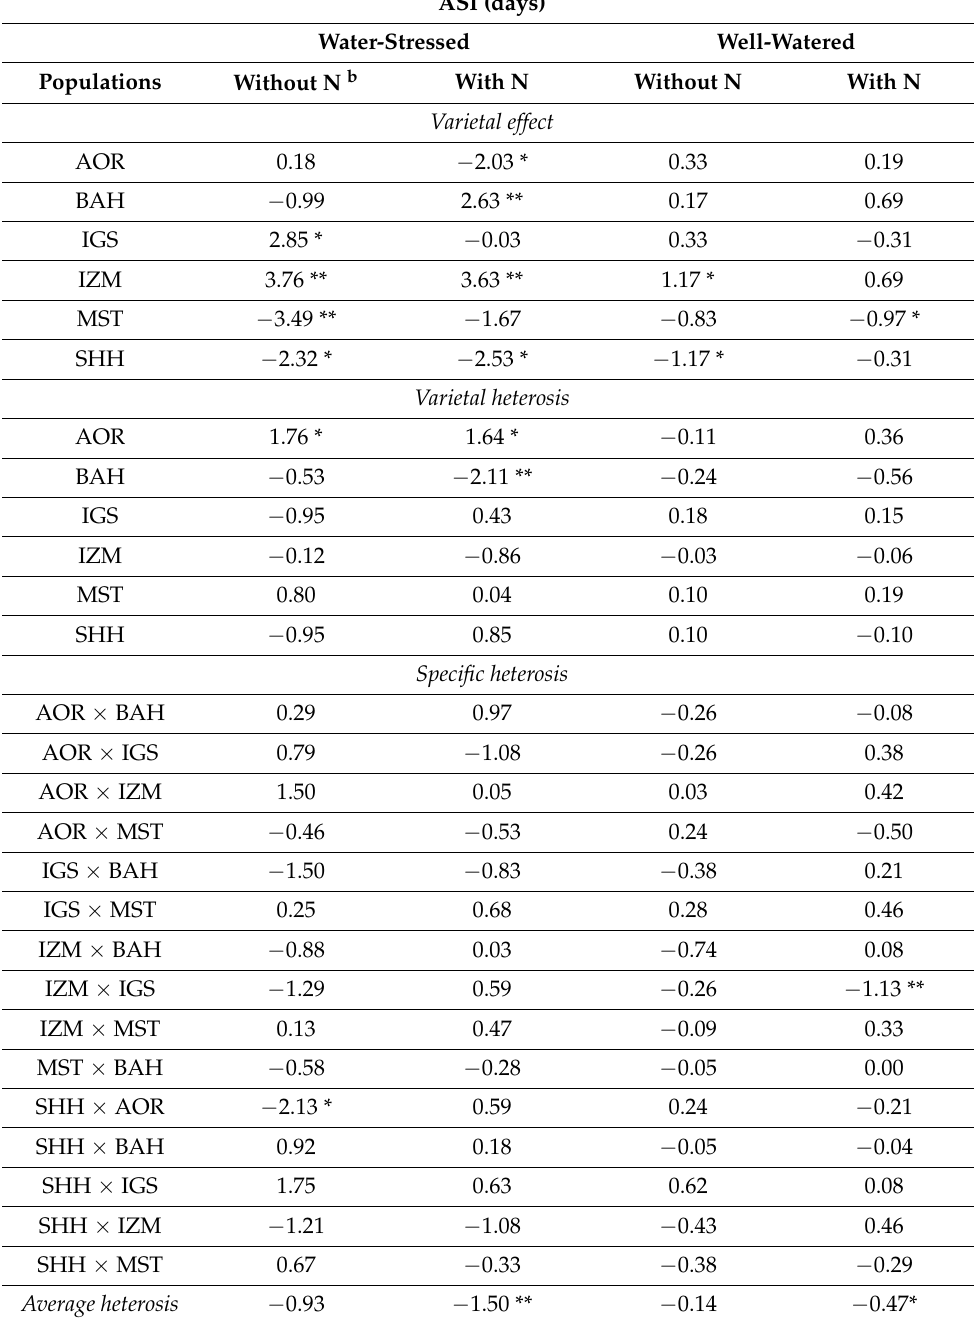
Table 3. Genetic parameters of ASI a and grain yield from the analyses of Gardner and Eberhart [42] (varietal effect, heterosis effect, specific heterosis, and average heterosis) for four traits in the diallel made among six Algerian maize populations evaluated in two years, in Algiers, under both managed drought and nitrogen